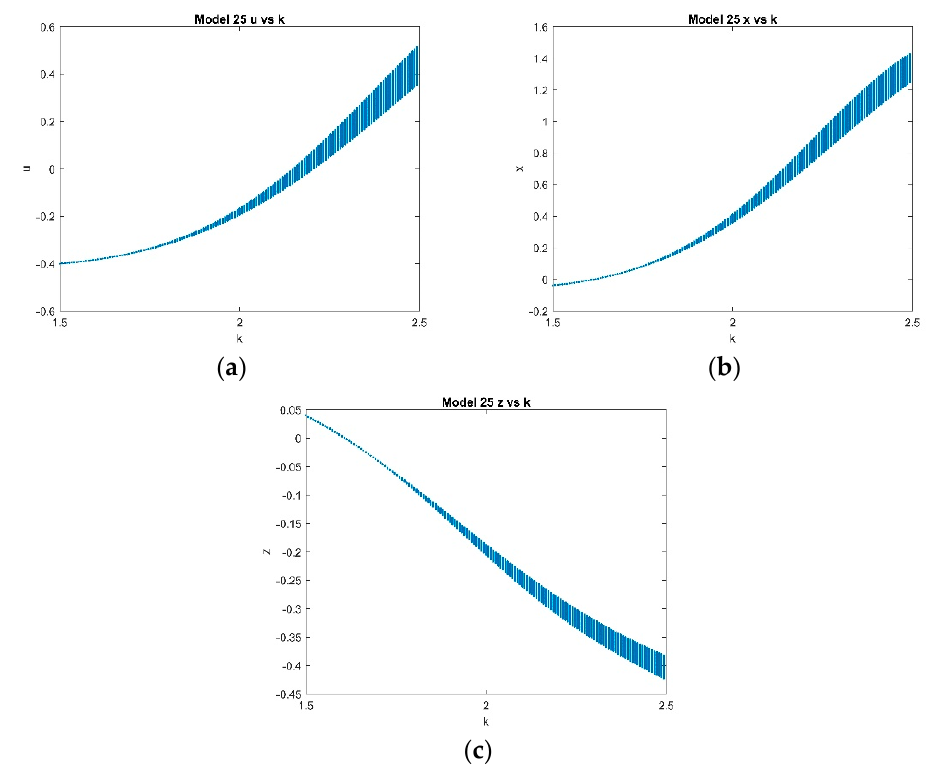
Figure 22. ESDDFD2 model (25); ( a ) u vs. k , ( b ) x vs. k , ( c ) z vs. k , at p = 1, α 5 = 0.3, k ∈ [ 1.5, 2.5 ] . Setting k = 2.45, phase portraits are given for models (22) through (25) in Figure 23. The phase portraits for CEFD, model (21), are given in Figure 24. Again, while the phase portraits for CEFD show chaos, it is lacking in the phase portraits for models (22) through (25).